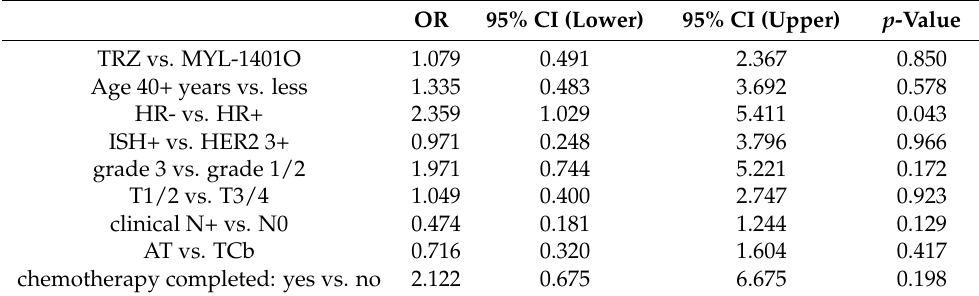
Table 5. Binary logistic regression for